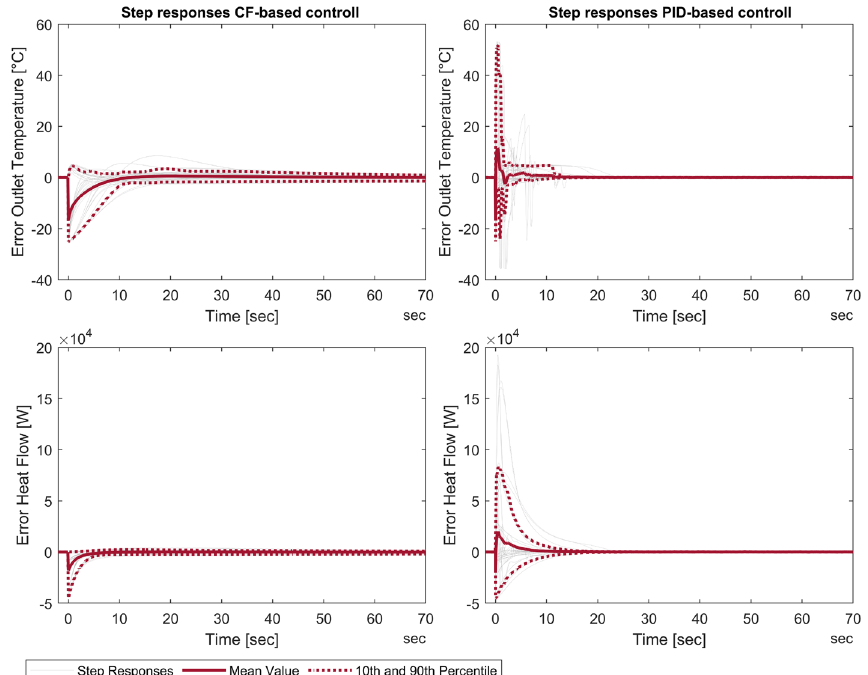
Fig. 9 Step responses as well as mean values and 10th/90th percentiles of all scenarios [own